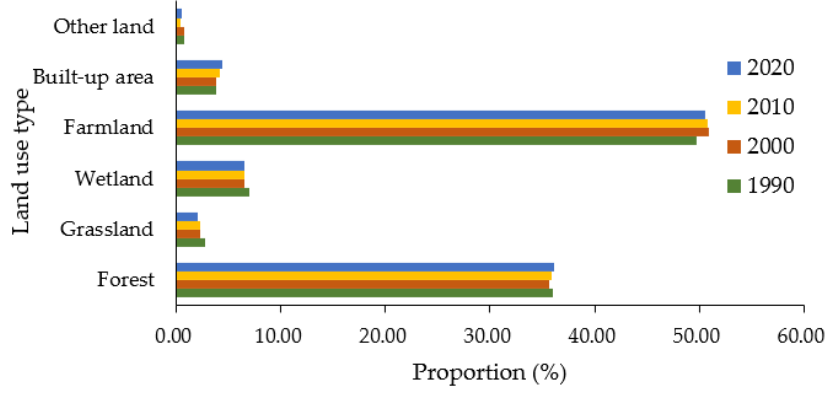
Figure 6. Proportions of land use types in each year.